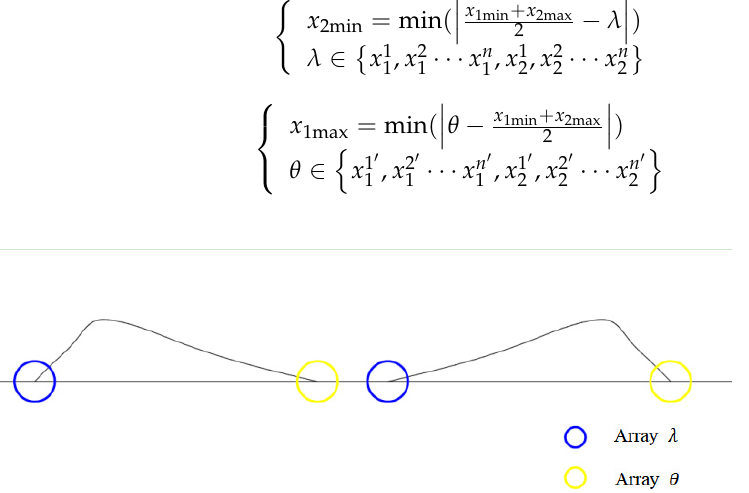
Figure 11. Multiple bubble defects. Type II and Type III bubbles are used to represent multiple bubbles. Blue circle represents the position of array λ . Yellow circle represents the position of array θ .